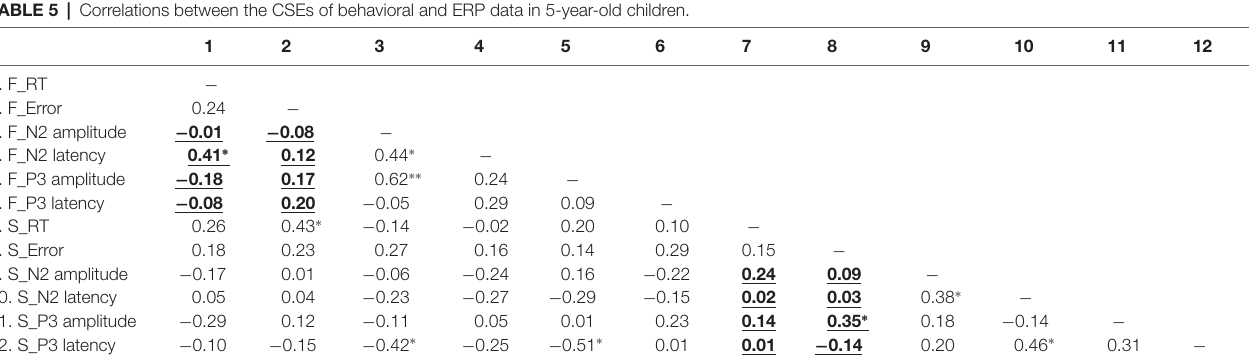
TABLE 5 | Correlations between the CSEs of behavioral and ERP data in 5-year-old